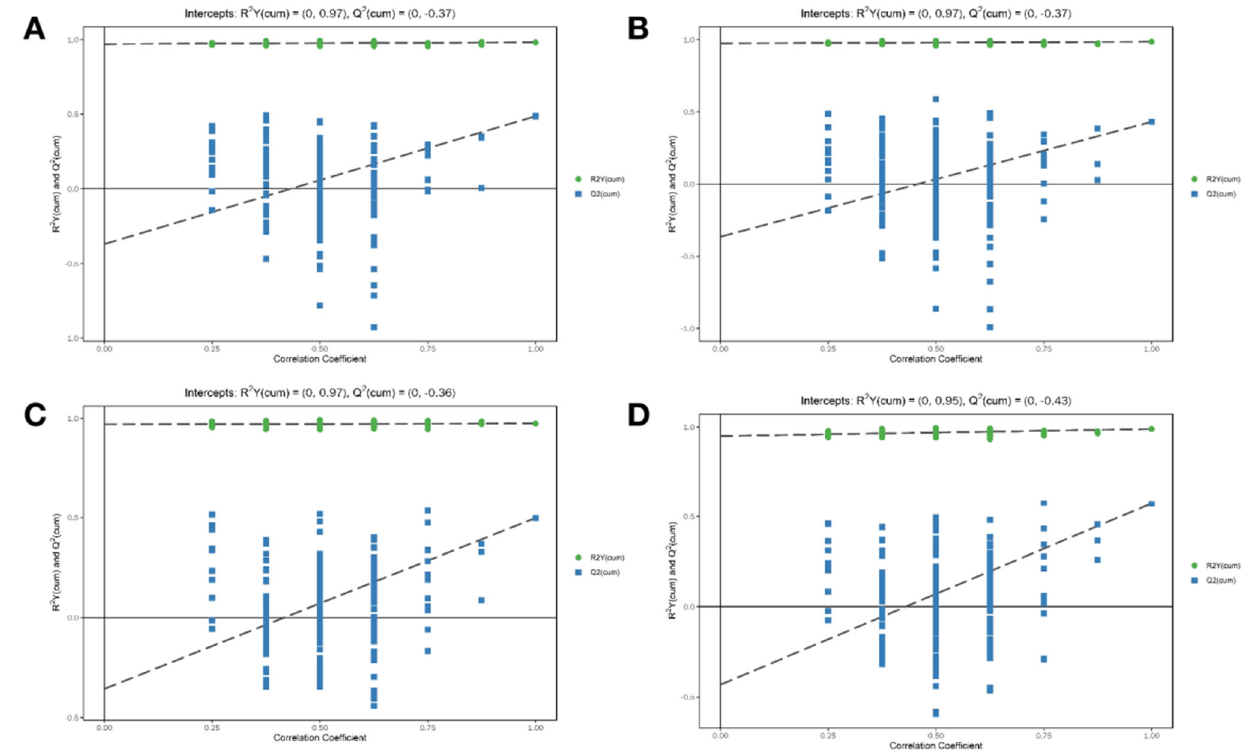
Figure 9. Permutation tests of the OPLS-DA model. ( A ) Normal Control group vs. CYP Model group (ESI+); ( B ) Normal Control group vs. CYP Model group (ESI − ); ( C ) CYP Model group vs. MP+CYP group (ESI+); ( D ) CYP Model group vs. MP+CYP group (ESI − ). Table 2. Differential metabolites in the liver and their change trends among